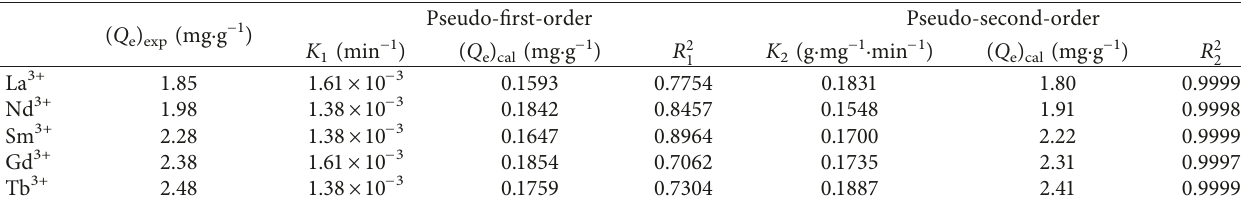
Table 2: Kinetic constants for pseudo-first-order and pseudo-second-order models for Ln 3+ sorption.